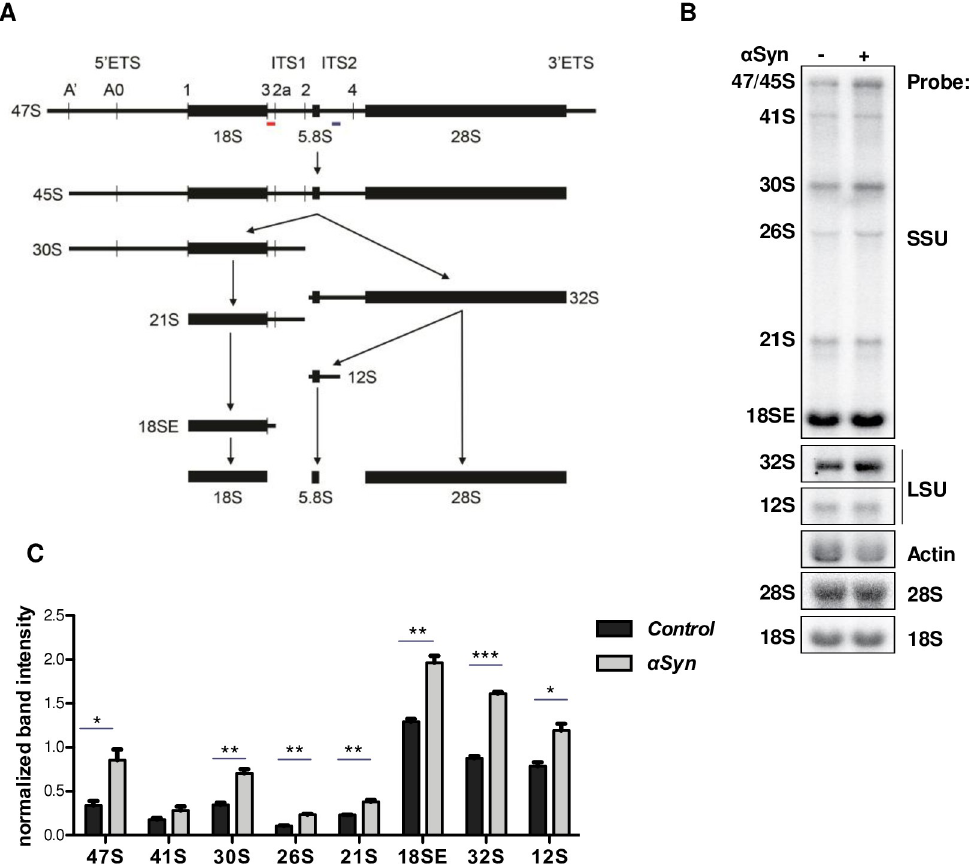
Fig 4. α Syn causes accumulation of pre-rRNA intermediates in human cells. (A) Schematic view of the major pre- rRNA intermediates in human cells. The initial 47S pre-rRNA transcript is processed to mature the 18S, 5.8S and 28S rRNAs via various pre-rRNA intermediates. The position of the SSU probe and LSU probe used for northern hybridization are indicated by red and blue lines respectively. ITS: internal transcribed spacer; ETS: external transcribed spacer. (B) Total RNA was extracted from HEK293 cells stably transfected with EGFP (control) or α Syn-EGFP. RNAs were separated by denaturing agarose gel electrophoresis and transferred to a nylon membrane. The mature 18S and 28S rRNA were visualized using specific hybridization probes. Northern blotting was performed with a probe hybridizing to the 5 0 end of ITS1 (SSU probe) for detection of 18S rRNA precursors, or with a probe hybridizing to ITS2 (LSU probe) for detection of 28S and 5.8S rRNA precursors. Actin transcript was used as a loading control. (C) Densitometric analysis of band intensities of the indicated transcripts relative to the actin loading control. Significance of differences was calculated with t-test ( � p < 0.05; �� p < 0.01; ��� p < 0.001; n = 3). maturation (SSU probe) or 28S rRNA maturation (LSU probe) (Fig 4A and 4B). The results revealed significant increase of the levels of 47S, 30S, 26S and 21S pre-rRNAs (18S precursors), as well as 32S and 12S pre-rRNAs (28S and 5.8S precursors) in presence of α Syn (Fig 4C), and no significant effect on the ratio of 28S to 18S rRNA (S6E Fig). These data support our findings from yeast cells that α Syn affects pre-rRNA levels.